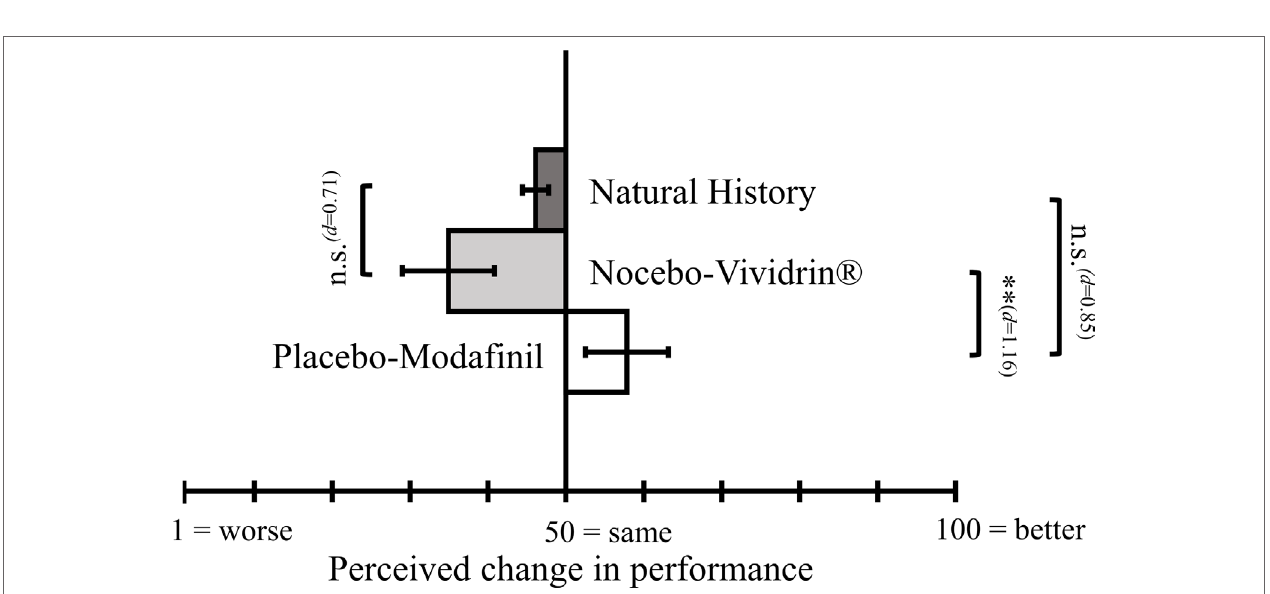
FIGURE 2 | Performance expectation (“I will perform well in the task”) before the first TAP assessment and after expectation manipulation via drug information and nasal placebo intake. Error bars represent standard errors. d = Cohen’s d . * p < .05. ** p < .01. *** p < .001.